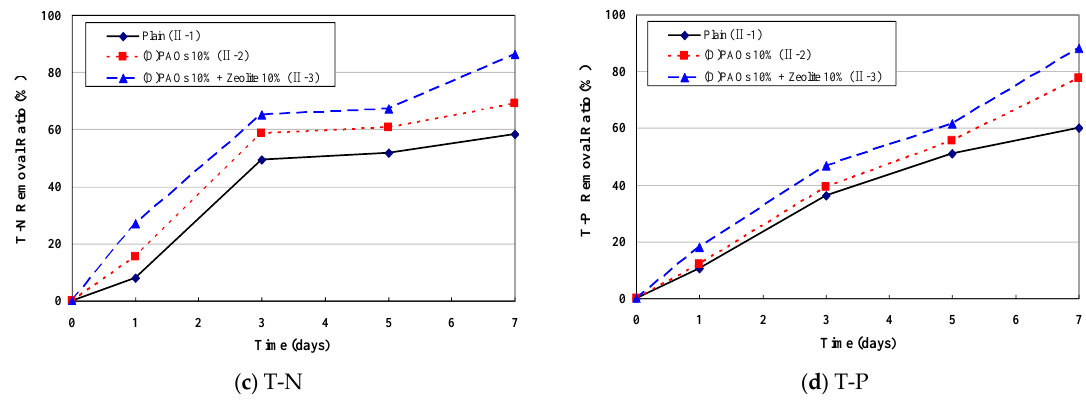
Figure 8. The result of the water purification test.